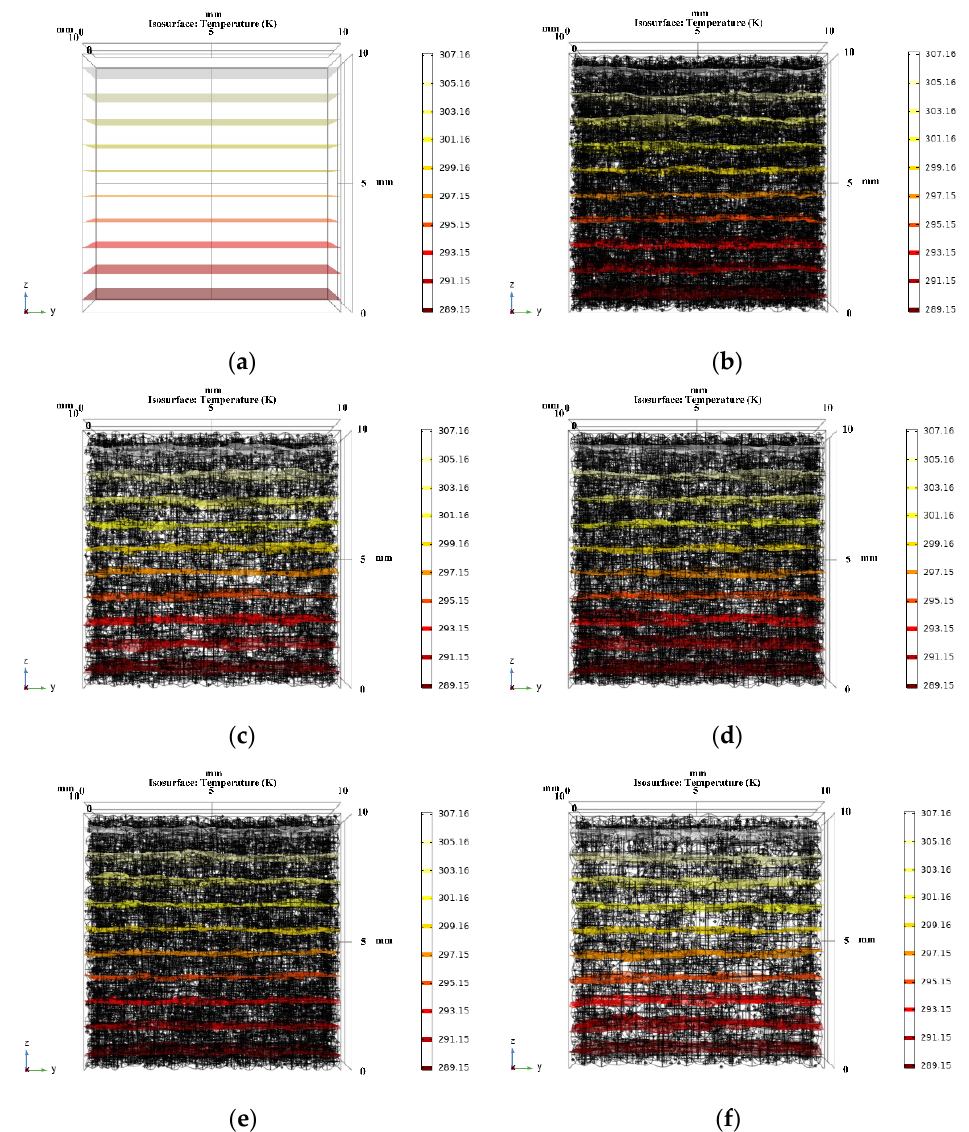
Figure 11. ( a ) Isotherms of reference concrete; isotherms of NAAC specimens at ( b ) 30 °C, ( c ) 35°C, ( d ) 40 °C, ( e ) 45 °C and ( f ) 50 °C.